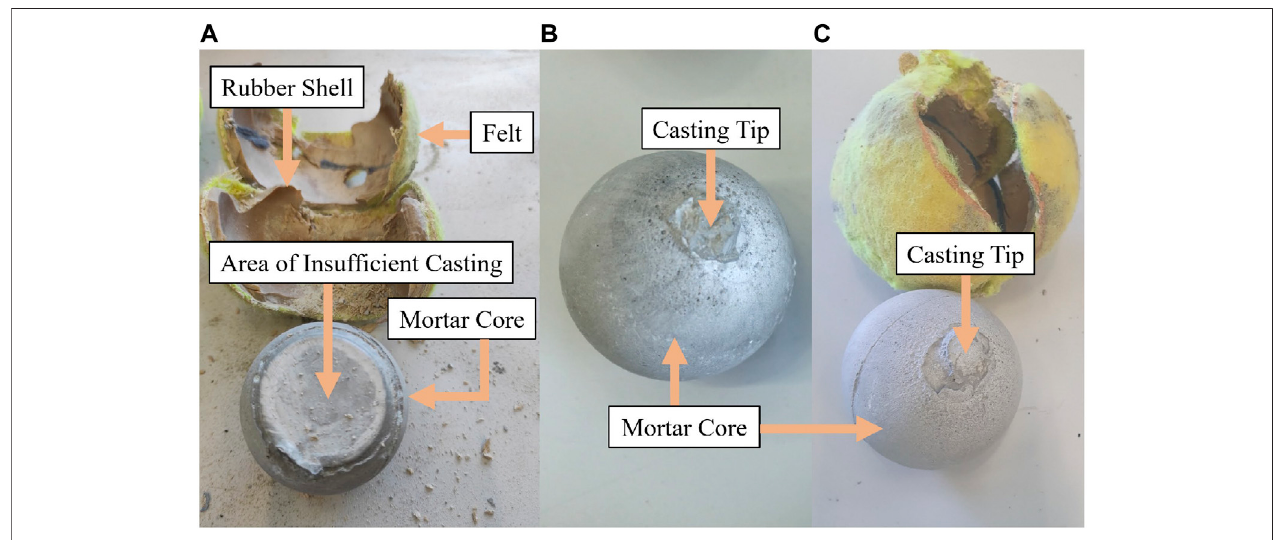
compressive force of W (cid:1) 8 kN and fl at concrete plates.